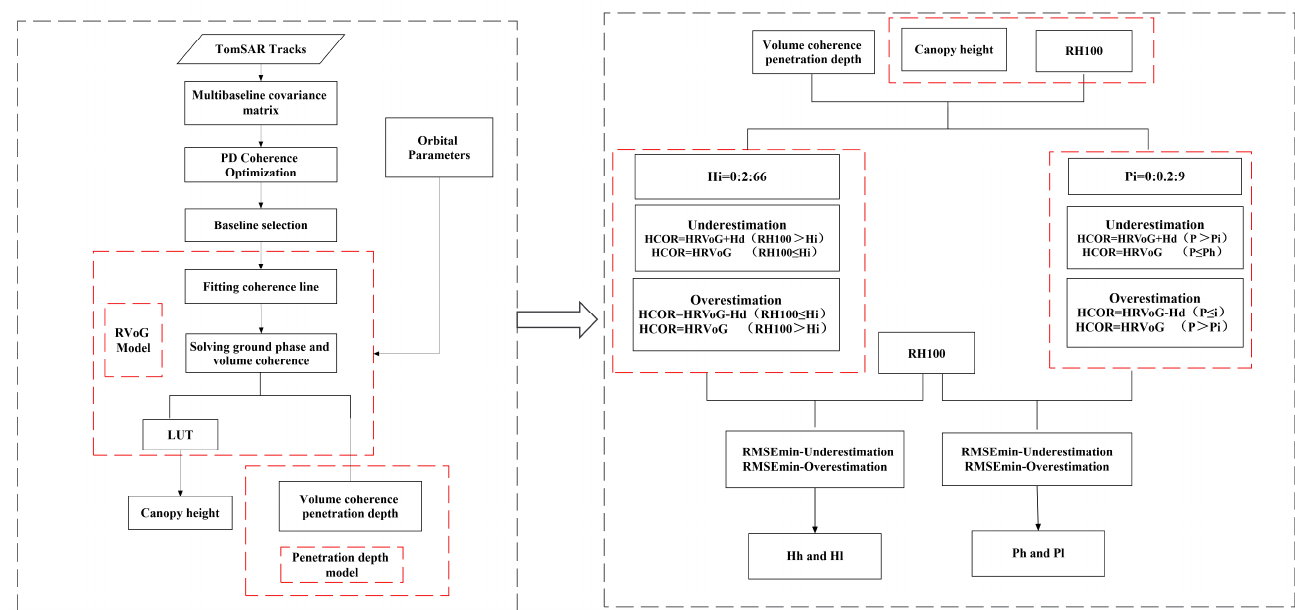
Figure 7. Technical workflow.